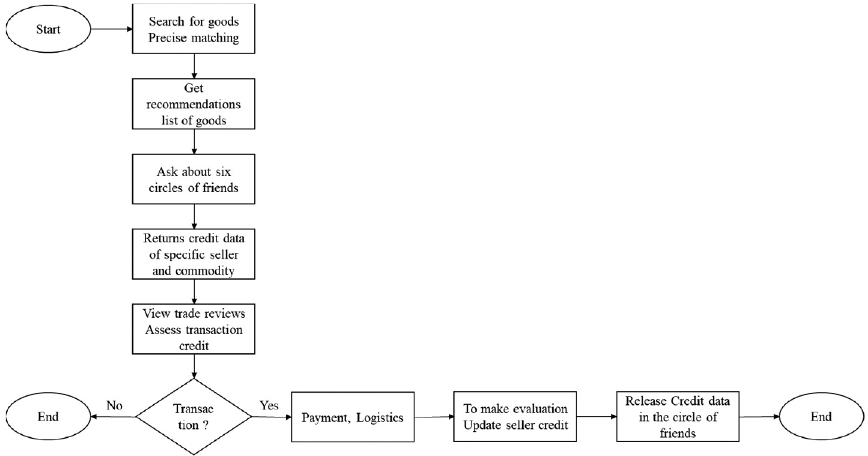
Figure 2. Process of